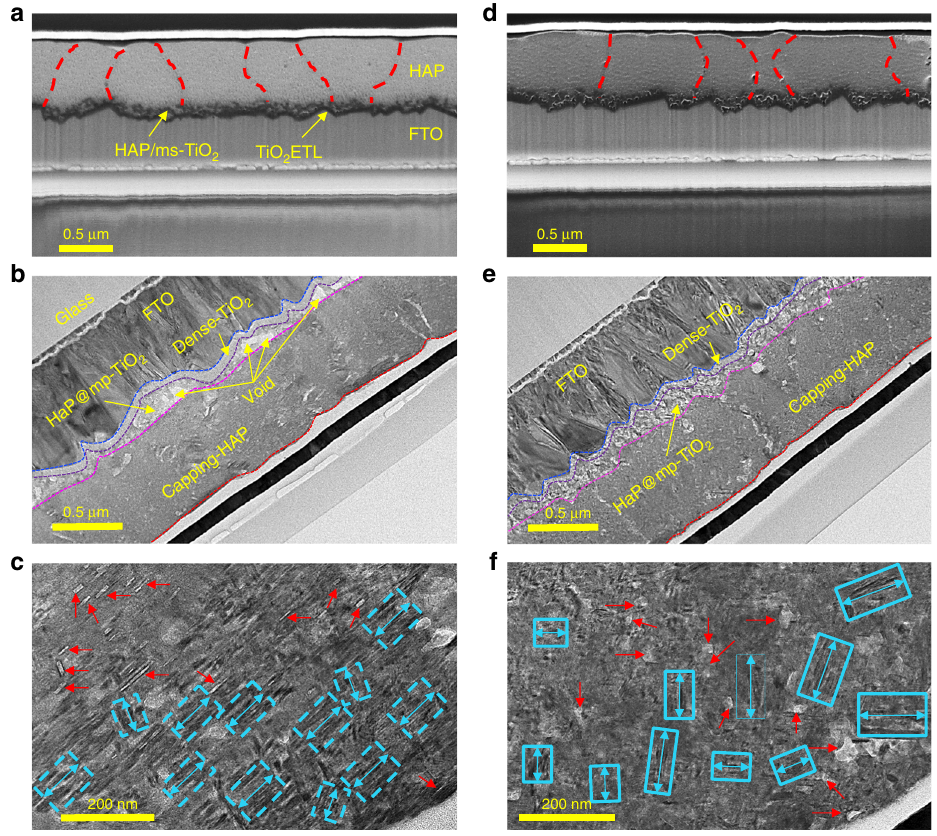
Fig. 4 FE-SEM and HR-TEM cross-sectional images ( a control-HaP, d w/-PbI 2 -HaP) and HR-TEM cross-sectional images ( b control-HaP, e w/-PbI 2 -HaP). HR-TEM images c and f show magni fi cations of images b and e respectively, of the HaP layer area. Red arrows indicate unreacted HaP with PbI 2 residues (or clusters) and blue arrows in rectangles (dashed or solid) correspond to the direction of lattice